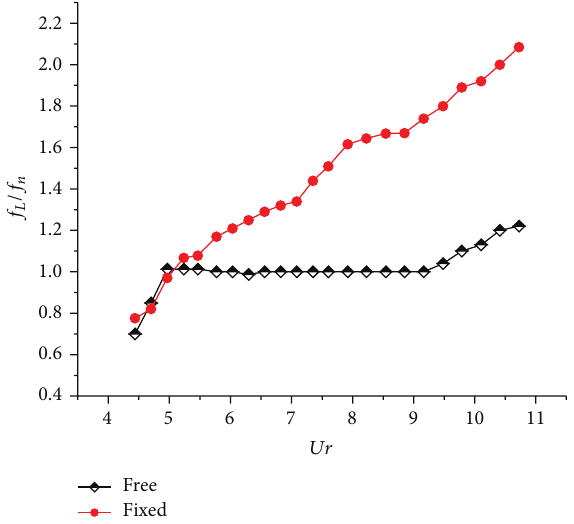
Figure 7: Variation of the frequency ratios versus the reduced wind